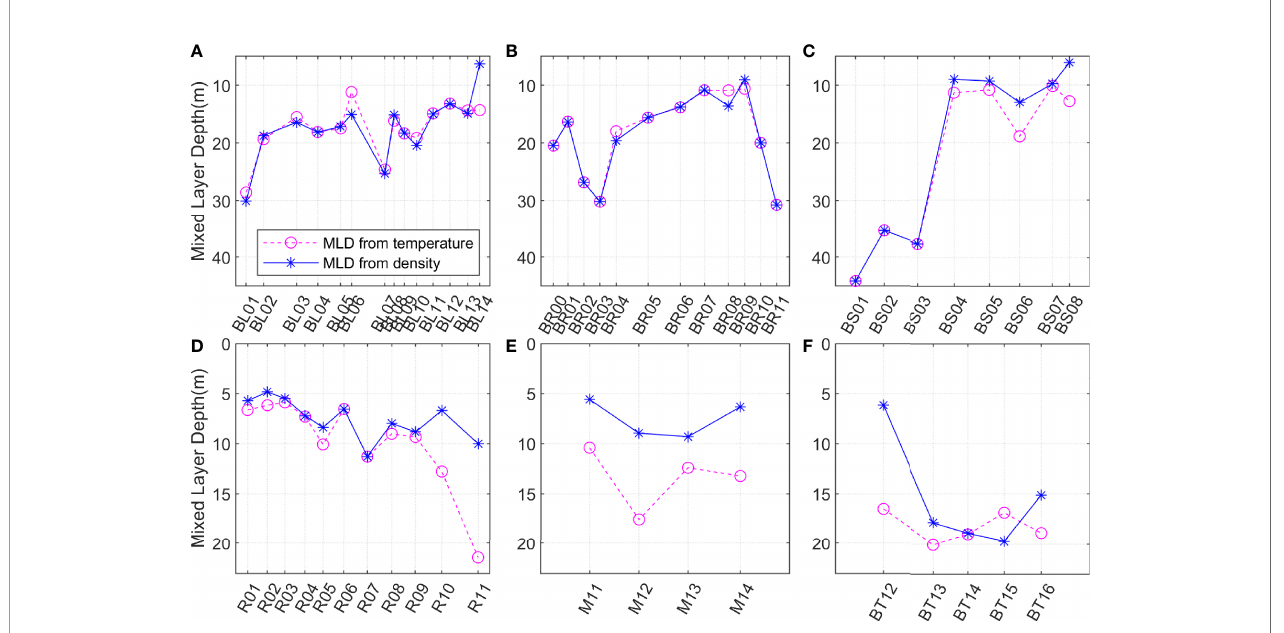
FIGURE 3 | The MLD from temperature and density. (A – F) represent the BL, BR, BS, R, M, and BT sections, respectively. The magenta dashed lines represent the MLDt calculated from the temperature, and the blue solid lines represent the MLD calculated from the density. Notice that the y-axis was